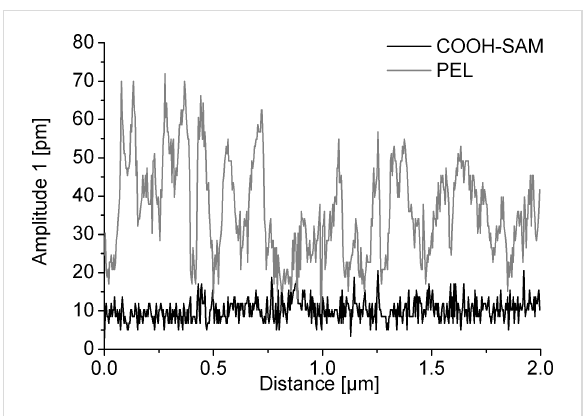
Figure 5: Cross-sections of the amplitude 1 images taken at 10 V for ZnO films deposited on COOH-SAM (black) and PEL (grey).